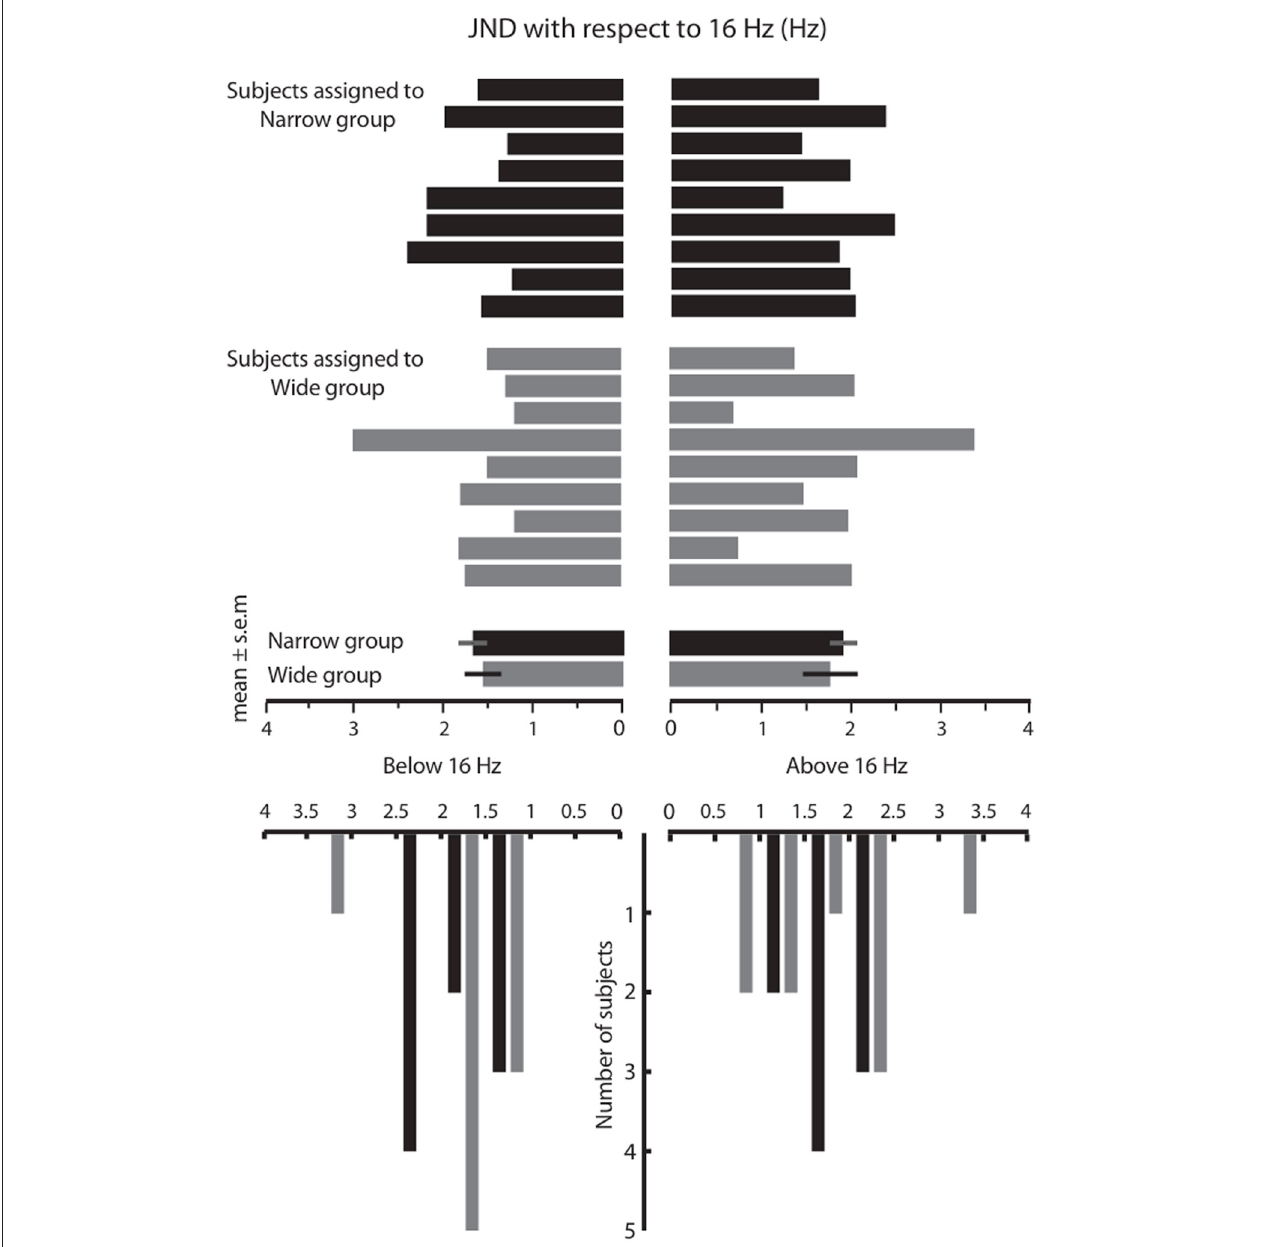
FIGURE 2 | Results of the acuity test in Phase 1. The top panel shows the just noticeable difference (JND) values for all subjects that participated in the Wide and Narrow conditions, measured separately below 16Hz (to the left) and above 16Hz (to the right).